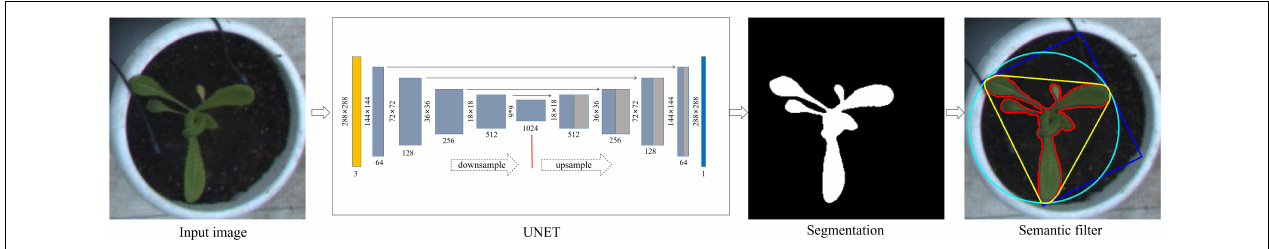
Growth rate index (GR)